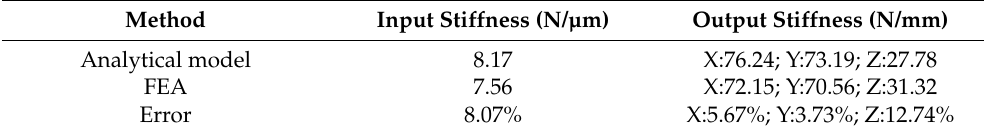
Figure 13. The first six natural frequencies of the platform: ( a ) the first natural frequency; ( b ) the second natural frequency; ( c ) the third natural frequency; ( d ) the fourth natural frequency; ( e ) the fifth natural frequency; ( f ) the sixth natural frequency. Table 4. Comparisons of FEA and the Analytical model.